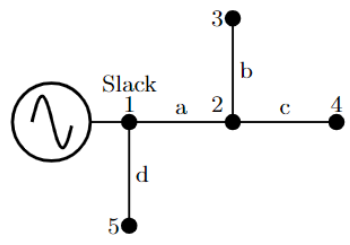
Figure 1. Single-line diagram of the proposed